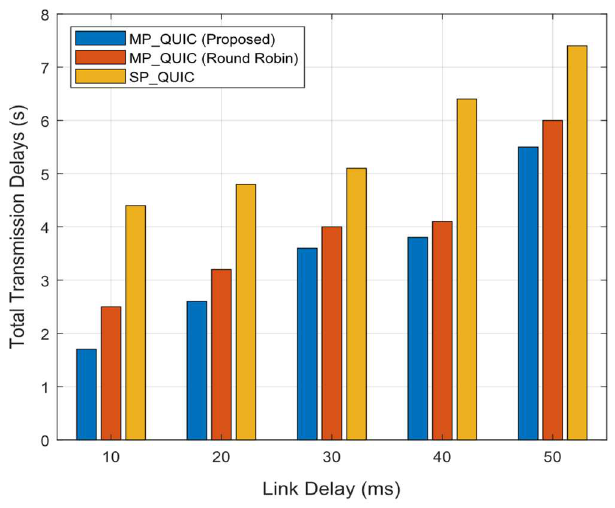
Figure 6. Total transmission delays for different link delays.